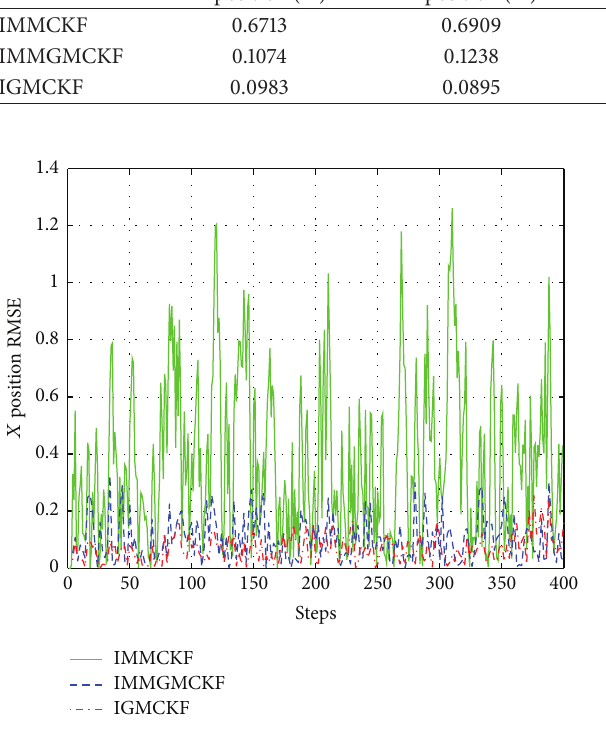
Figure 11: X velocity RMSE.